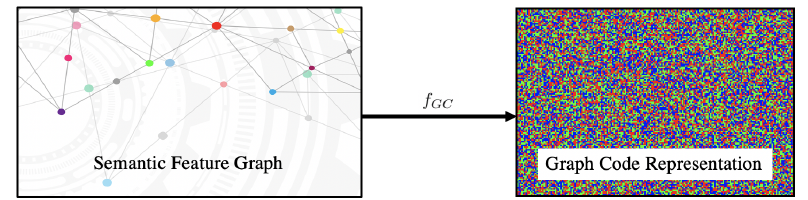
Figure 7. Illustration of the graph code